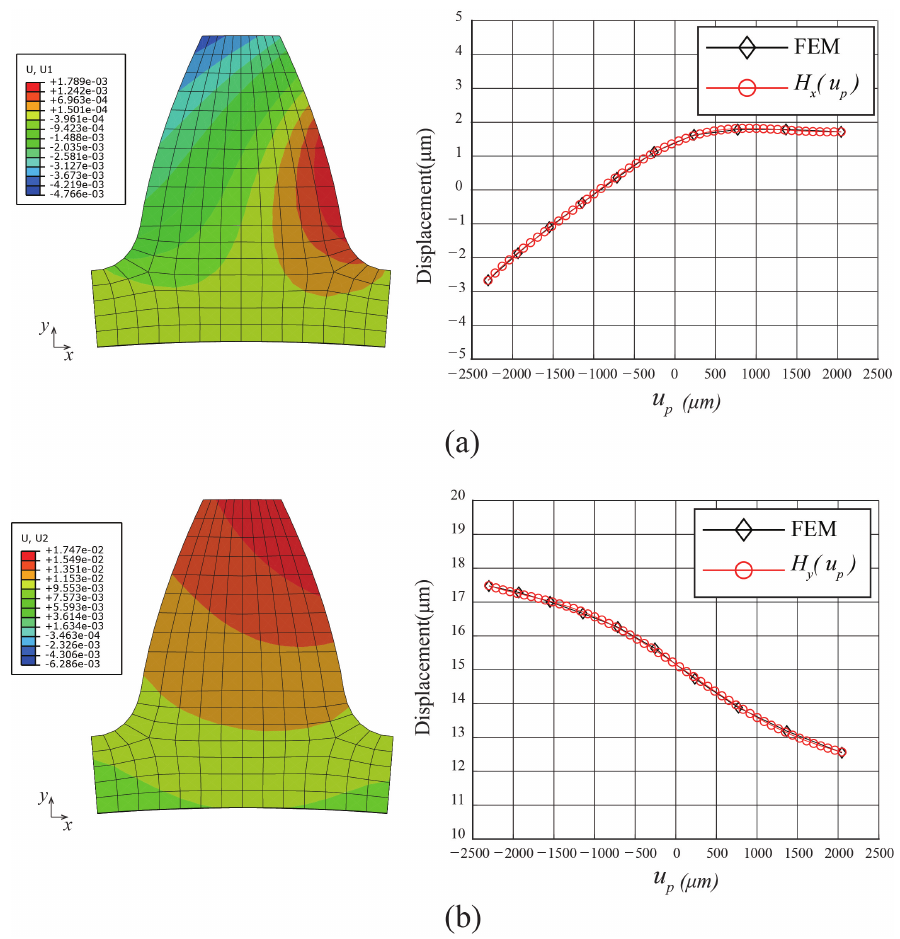
Figure 7. Thermal analysis results. ( a ): contour of displacement on x (left) and displacement on x along u p (right). ( b ) : contour of displacement on y (left) and displacement on y along u p